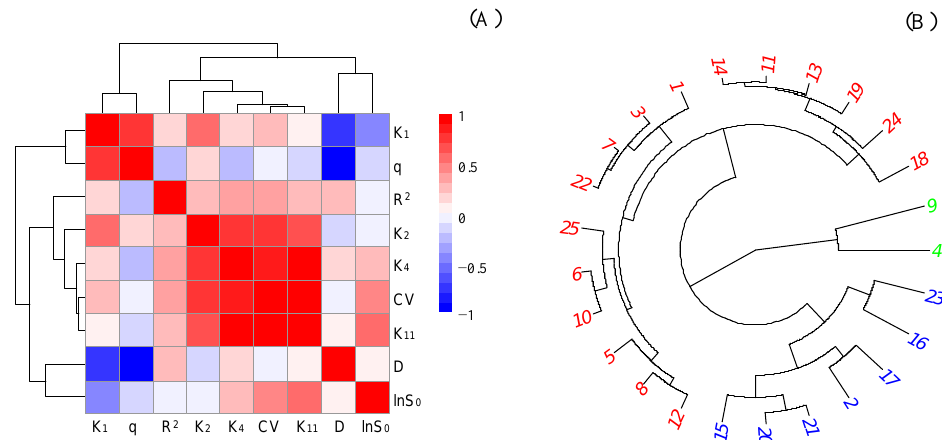
Figure 16. Heat map ( A ) and cluster map ( B ) of the urban systems in the TCE. The numbers 1–25 denote Heilongjiang, Jilin, Liaoning, Jing-Jin-Ji, Henan, Shanxi, Shandong, Anhui, Su-Hu, Zhejiang, Hubei, Hunan, Jiangxi, Fujian, Guangdong, Hainan, Guangxi, Guizhou, Yunnan, Chuan-Yu, Shaanxi, Gan-Ning, Qinghai, Xinjiang, and Inner Mongolia, respectively. The green, blue and red in the numbers 1–25 represent the three classification